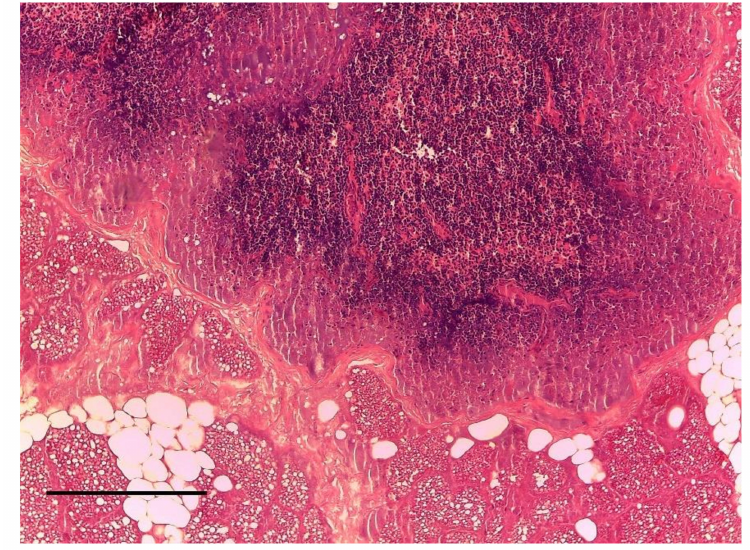
Figure 3. Mammary gland. Not purulent mastitis. H&E Staining, bar = 100 µ